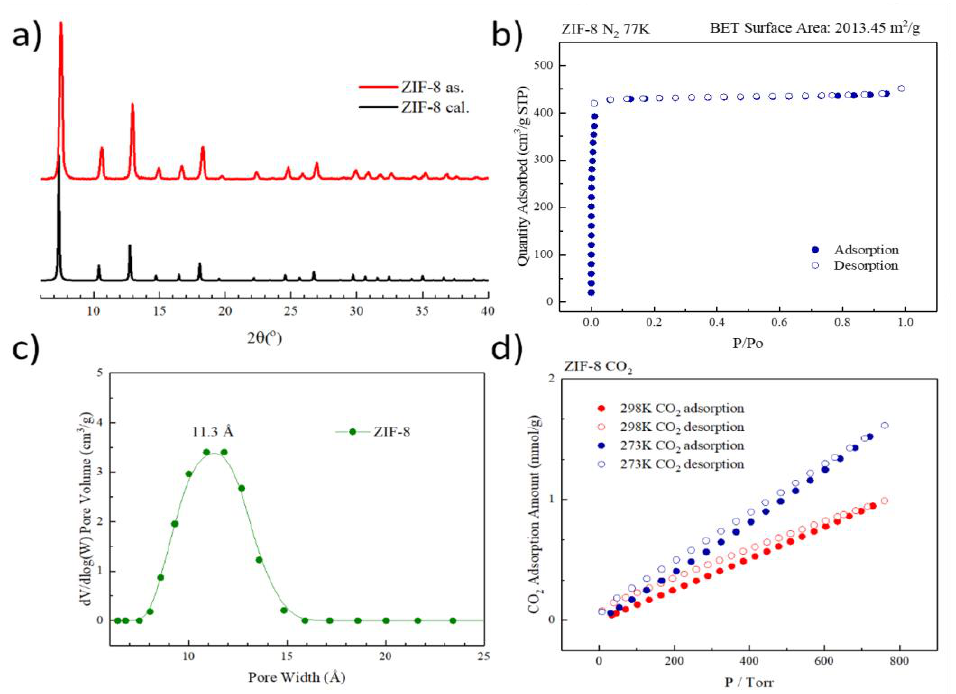
Figure 1. Characterization of synthesized ZIF-8. ( a ) the PXRD pattern, ( b ) N 2 adsorption isotherm (77 K), ( c ) pore size distribution, and ( d ) CO 2 adsorption isotherm (298/273 K).